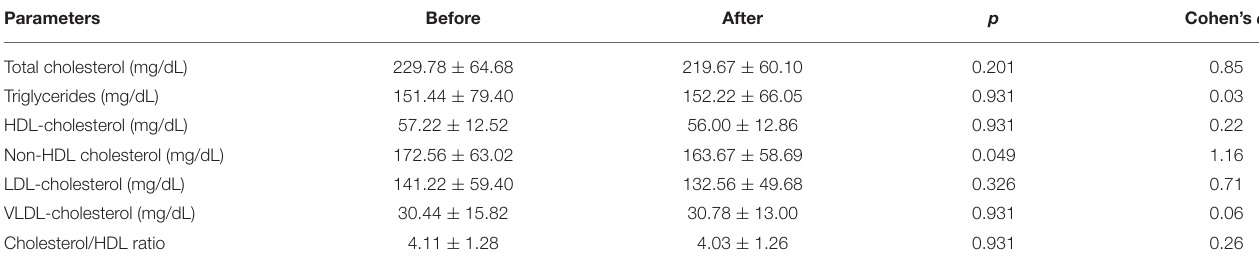
TABLE 2 | Effect of group TC on lipid profiles.